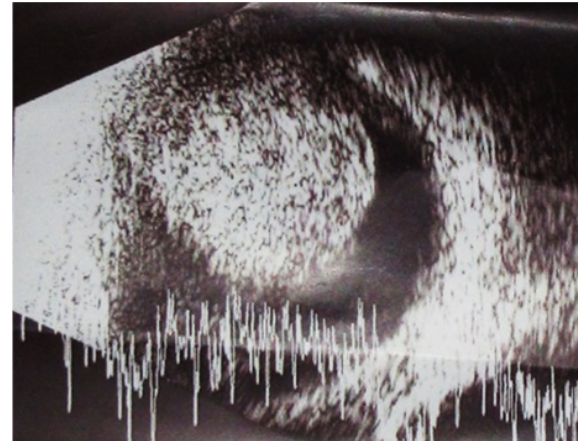
Figure 2: Ultrasonography showing a mushroom-shaped, elevated, solid lesion with regular internal structure and low to moderate internal reflectivity suggestive of choroidal melanoma